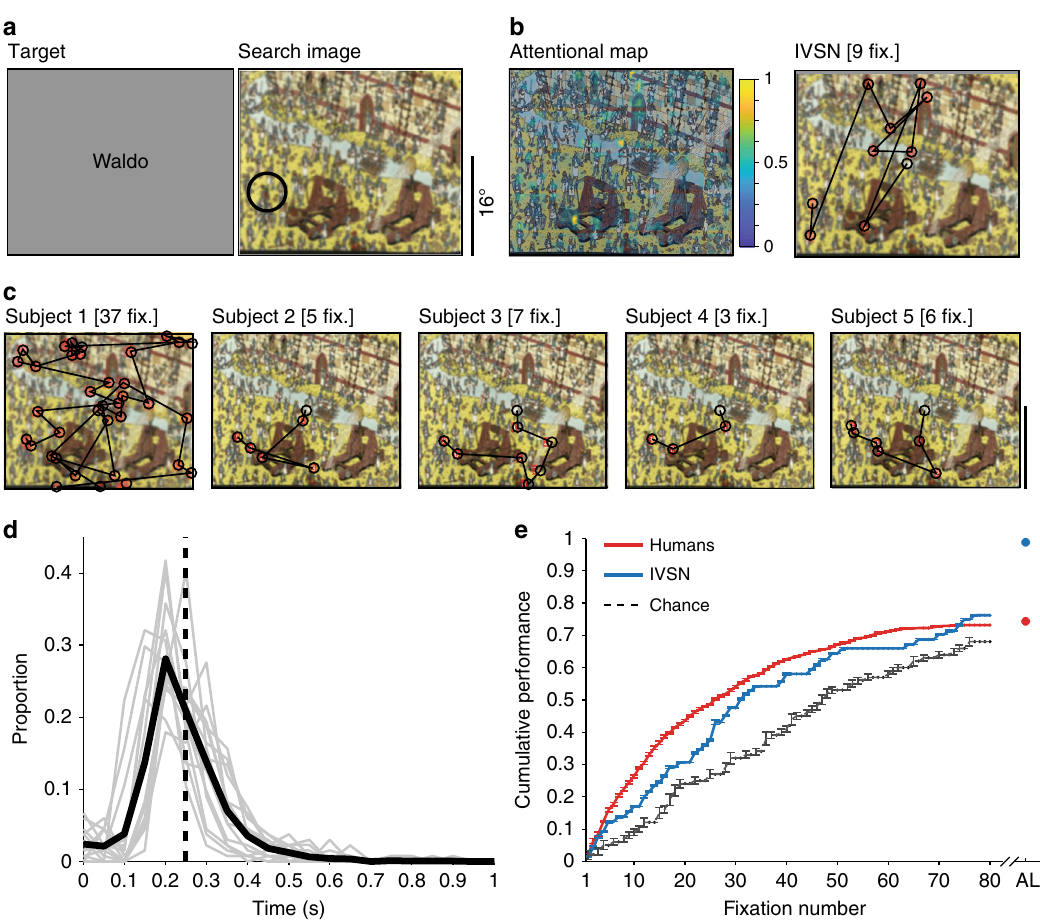
Fig. 5 Experiment 3 (Waldo images). The format and conventions follow those in Fig. 3. Due to copyright, we replaced the picture of Waldo shown during the actual experiment in the target image ( a ) with the text “ Waldo